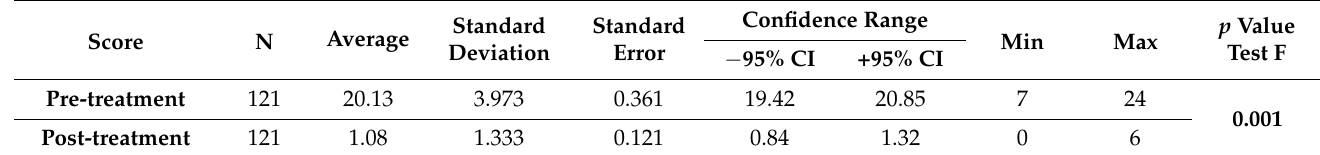
Table 11. Statistical indicators of the assessment score of the degree of pre- and post-treatment vision